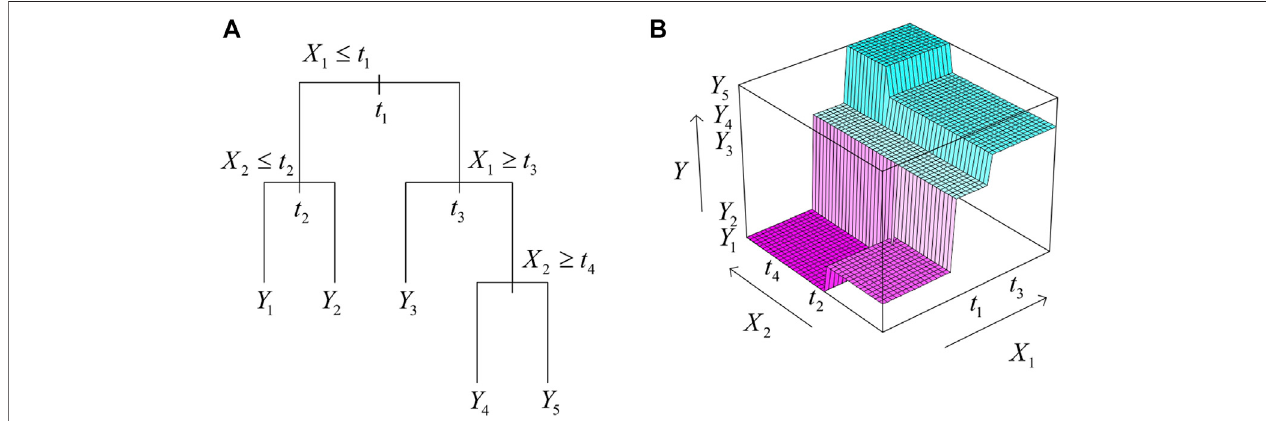
FIGURE 4 | (A) shows a single regression tree with a response Y , in which X 1 and X 2 are two predictor variables, and t 1 , t 2 , etc. are split points. (B) shows the regression tree ’ s prediction surface. Source: Adapted from (Hastie et al., 2009, p.